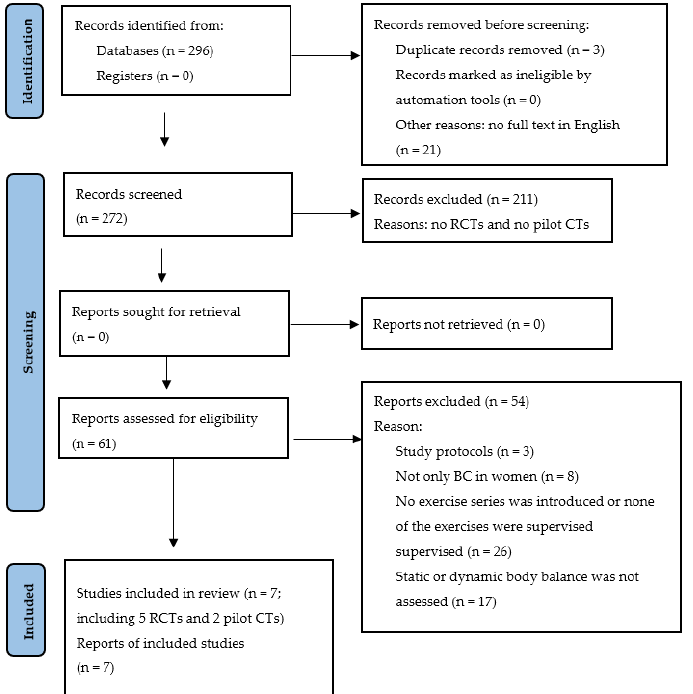
Figure 1. The literature search flow diagram (BC—breast cancer; RCTs—randomized clinical trials; pilot CTs—pilot clinical